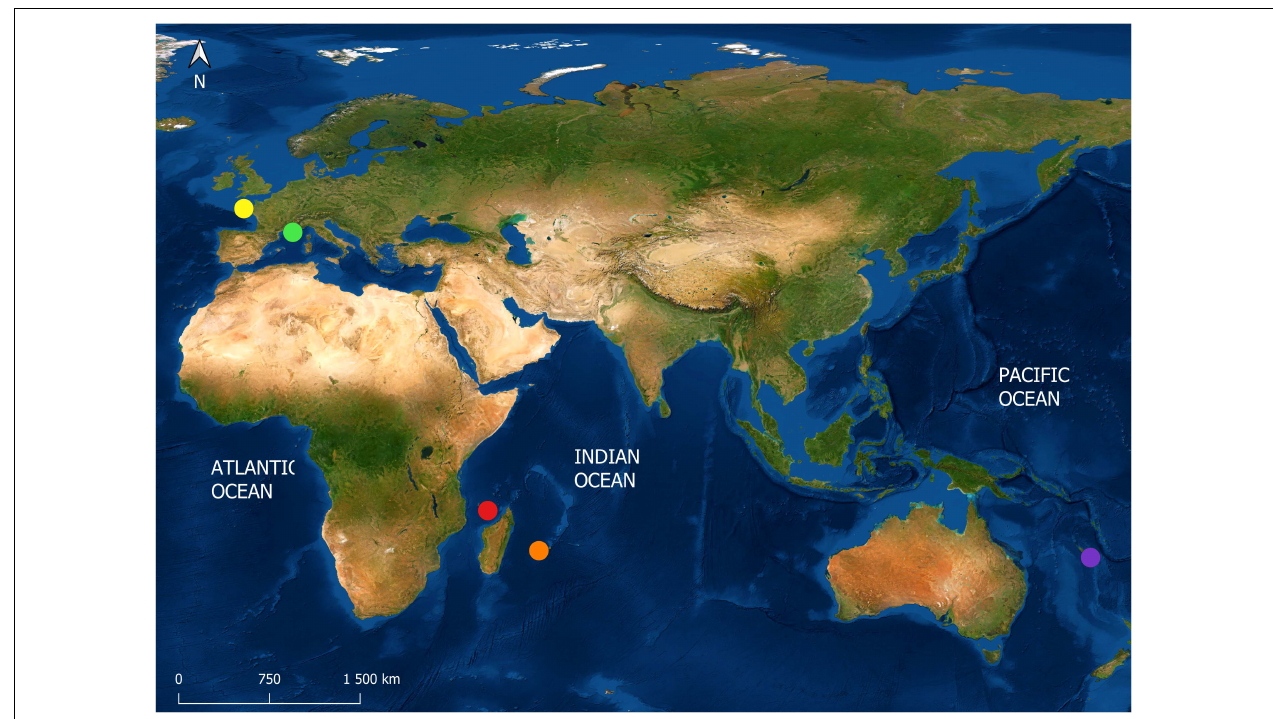
FIGURE 2 | Regions where the STAVIRO protocol was implemented: New Caledonia (purple), Reunion Island (orange), Mayotte Island (red), Mediterranean Sea (green) and Atlantic Ocean (yellow).